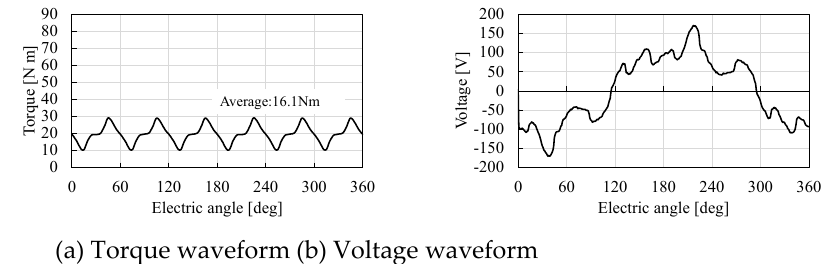
Figure 9. Torque waveform and phase voltage waveform in rotation speed of 52,000 min − 1 , input current of 356 Arms, and beta angle of 78 degrees.